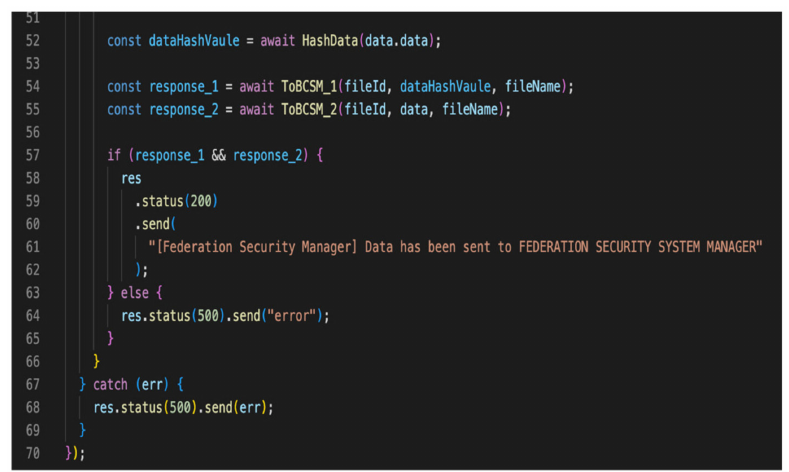
Figure 10. Screenshot of some restricted functionality in FSSM